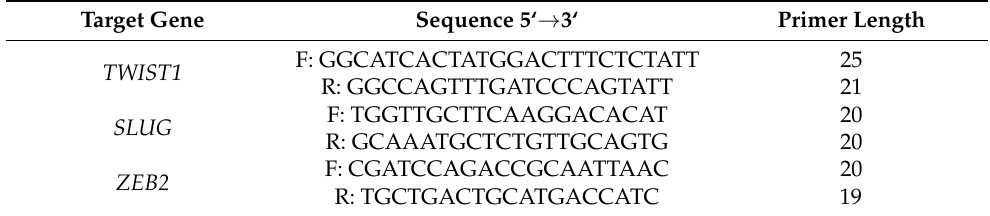
Table 1. Primers for